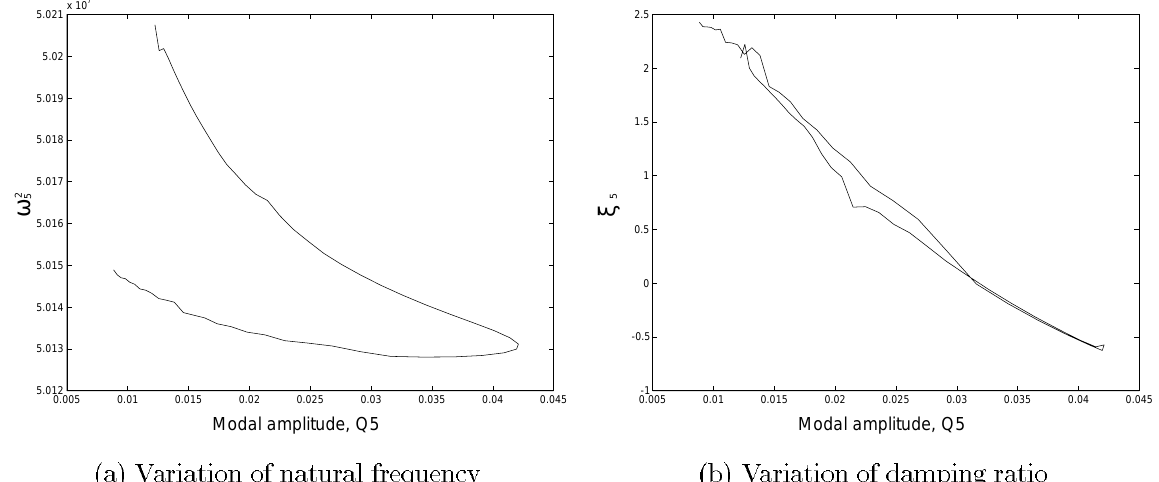
Fig. 13. Effect of erroneous underlying linear linear